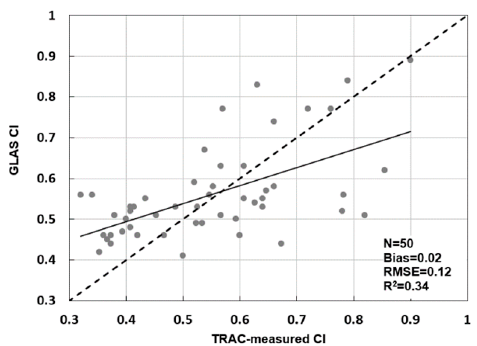
Figure 5. Evaluation of the GLAS CI using TRAC-measured CI. The solid line represents the linear fits of the TRAC-measured CI with GLAS CI. fits of the TRAC-measured CI with GLAS